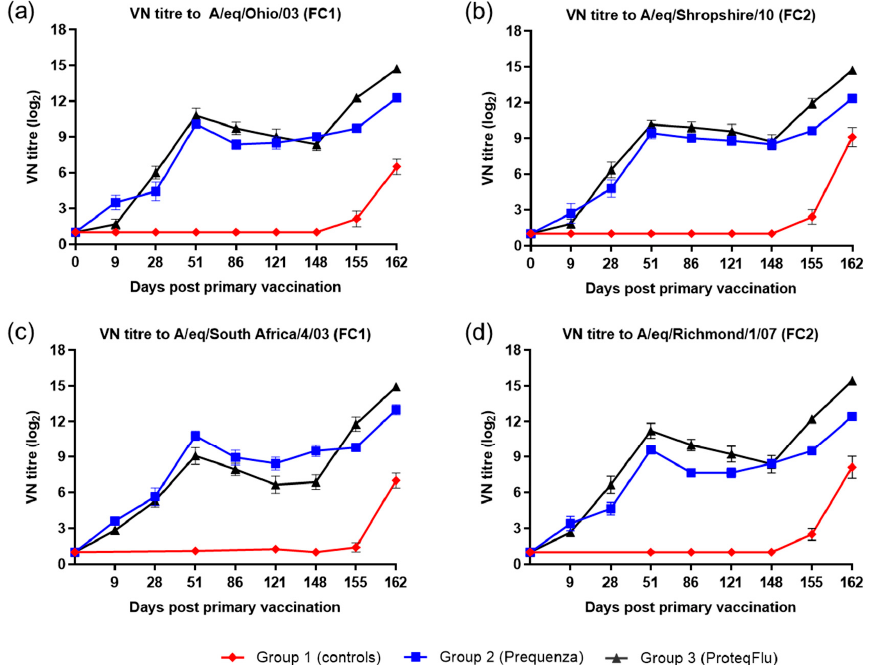
Figure 3. Mean virus neutralisation (VN) antibody titre response in groups 1–3 against H3N8 EIV ( a ) A/equine/Ohio/03 (FC1), ( b ) A/equine/Shropshire/10 (FC2), ( c ) A/equine/South Africa/4/03 (FC1) and ( d ) A/equine/Richmond/1/07 (FC2). Day 0, V1; Day 28, V2; Day 148, challenge. Red diamond = group 1, unvaccinated control group; blue square = group 2, Equilis Prequenza-vaccinated group; black triangle = group 3, ProteqFlu-vaccinated group. Error bars represent SEM. A titre of <2 was converted to 1 for graphical presentation. Vaccines 2019 , 7 , x